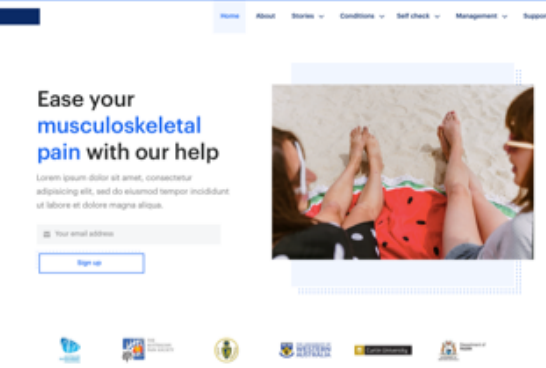
Figure 2. Screenshots of the 2 prototype websites: to the left, the round, soft version is shown, and to the right, the geometric version.